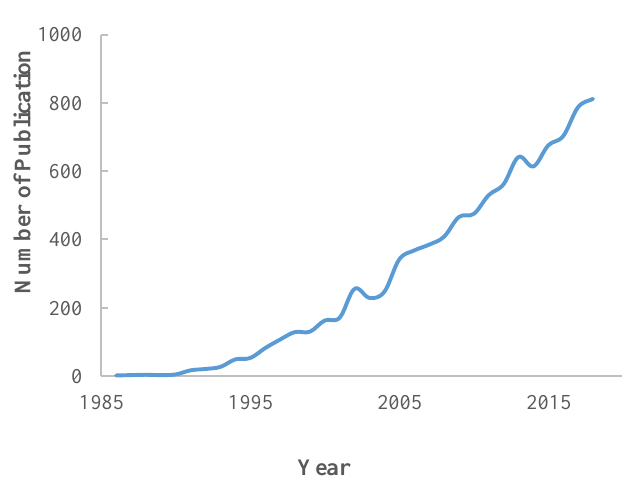
Figure. 1. Number of publications per year related to NF in various